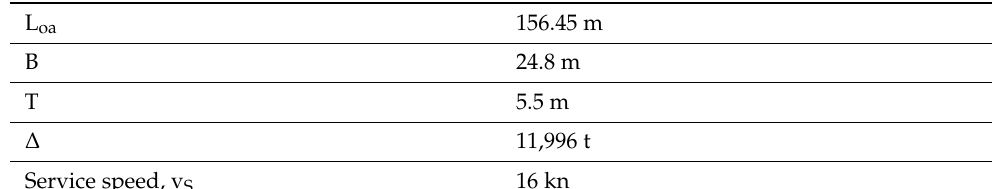
Table 1. Main dimensions of the RoPax ferry.